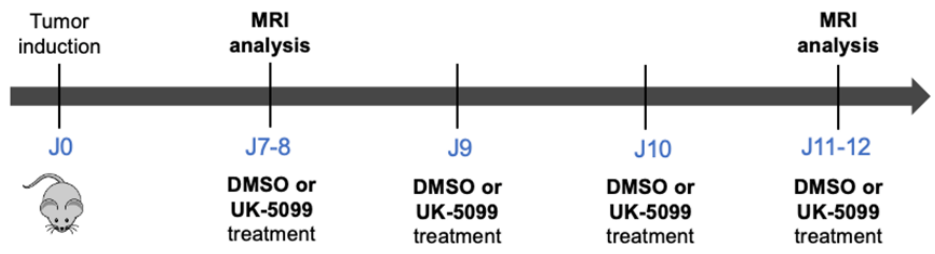
Figure 3. Experimental protocol to assess the effect of UK-5099 on extracellular pH in vivo .